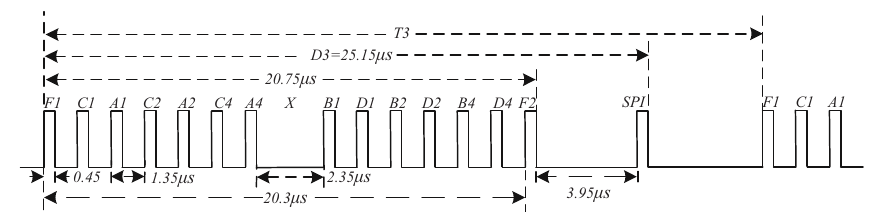
Figure 3. The baseband signal of SSR